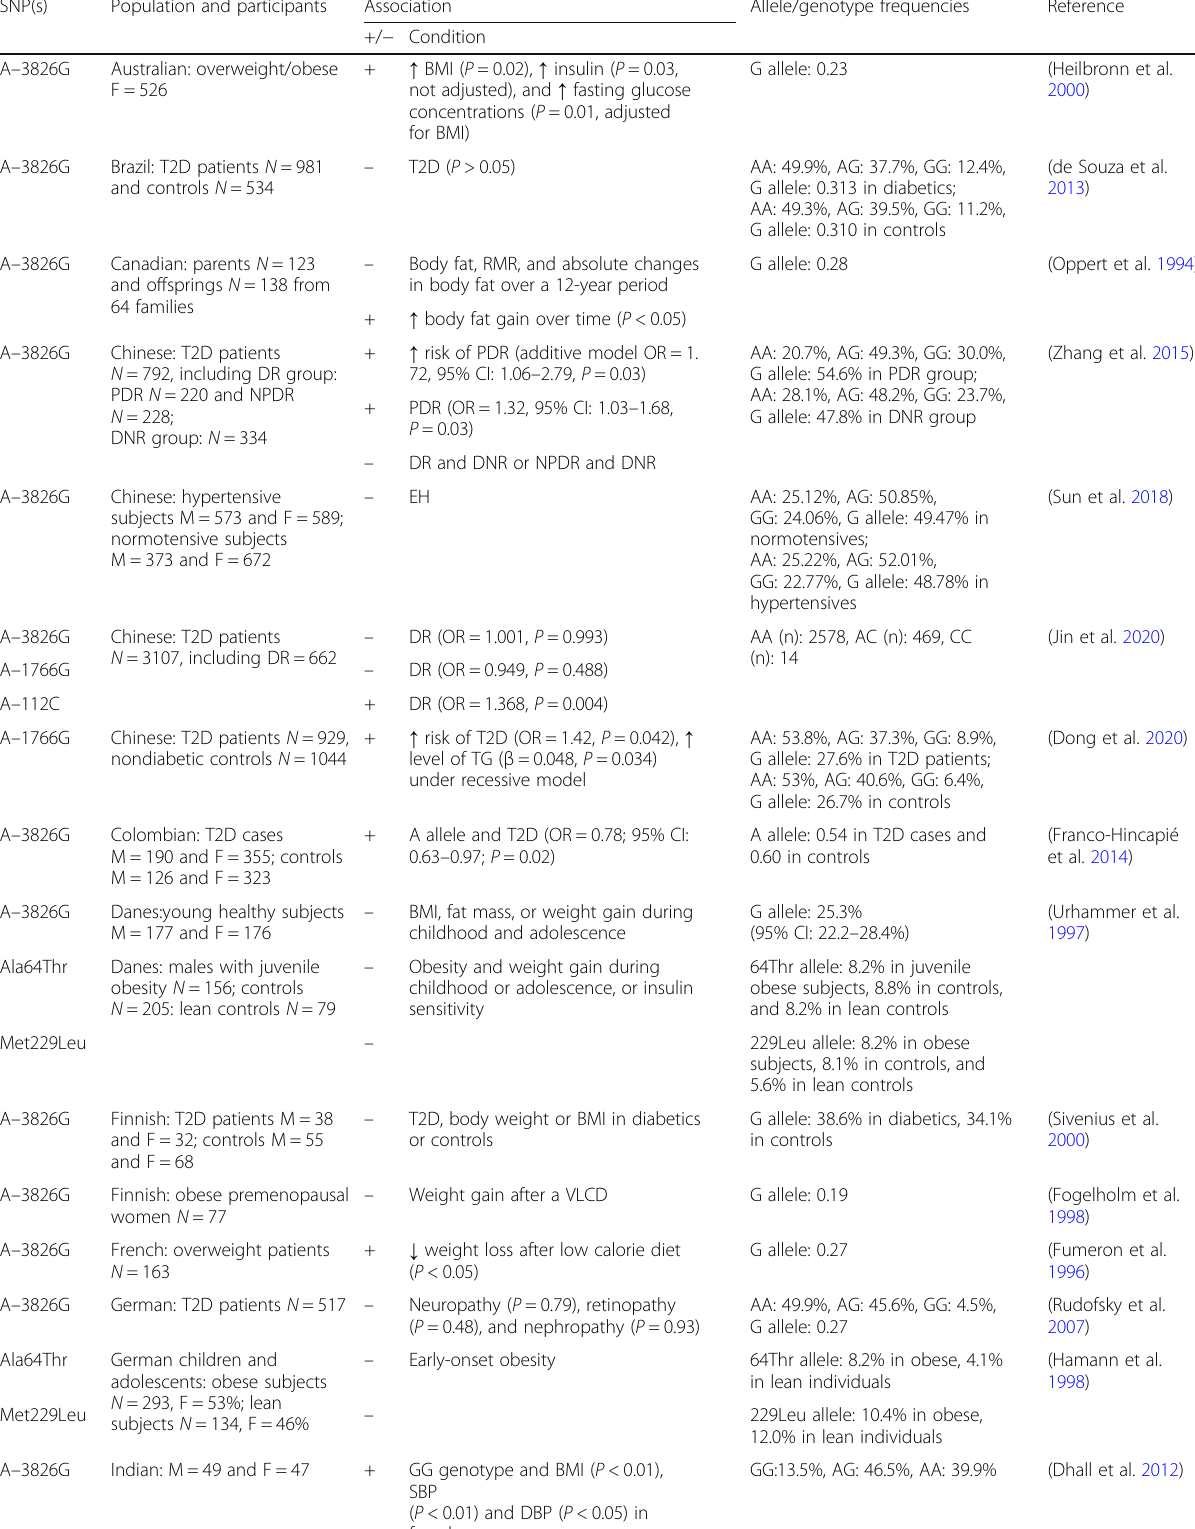
Table 1 Studies on the association between the Ucp1 polymorphisms and CMDs or CMD risk factors in different populations SNP(s) Population and participants Association Allele/genotype frequencies